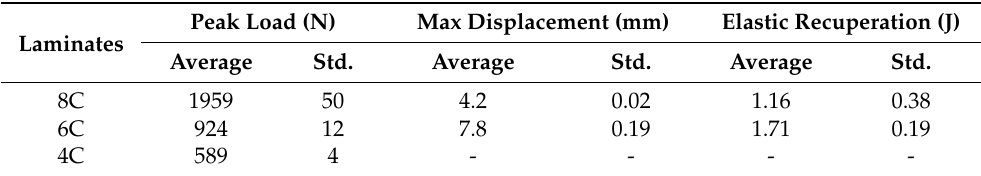
Table 4. Average values of the peak load, maximum displacement and elastic recuperation for composite cylindrical